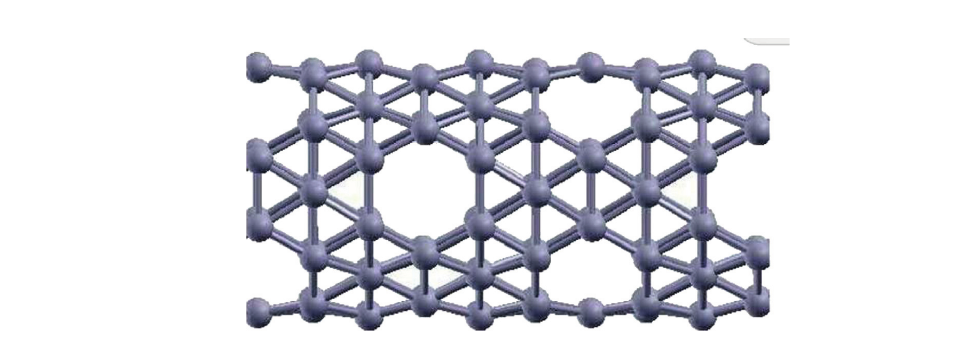
NS l � 0 (mod 3); (b) l � 2 (mod 3). lq : (a) α